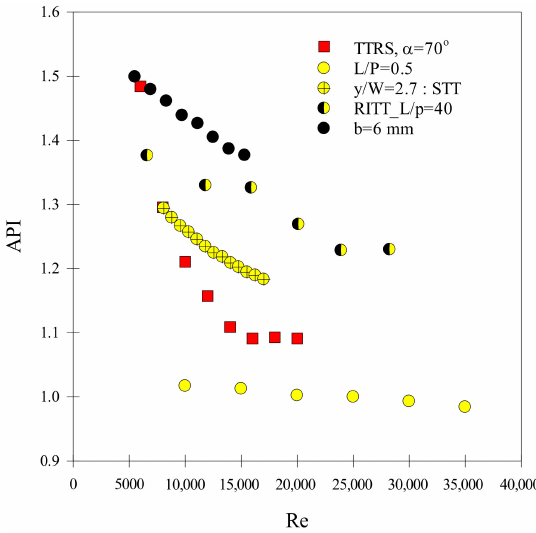
Figure 9. Benchmarking of API